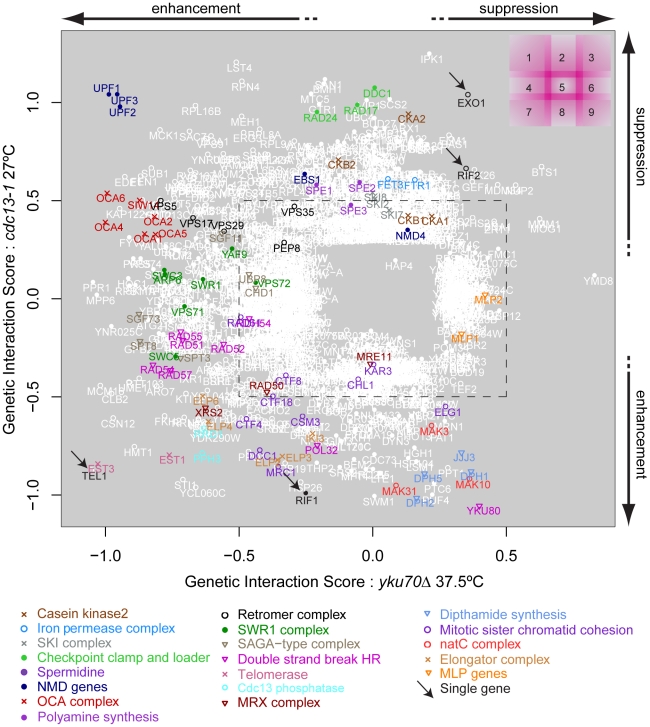
Genetic interaction strength (GIS) comparison between cdc13-1 and yku70Δ.Genes that significantly interacted with cdc13-1 or yku70Δ are shown, most genes did not interact and would be placed in the centre of the plot. Genes encoding components of selected protein complexes (or proteins which work closely together towards the same function) are indicated by colour-co-ordinated text and symbols. Genes that interact with both cdc13-1 and yku70Δ are open white circles, those that interact with just one mutation are filled white circles. Different regions of the plot are indicated on the top right and borders between regions are intentionally blurred/overlapping as there are not precise cut-offs. An arbitrary GIS cutoff of +/−0.5 is indicated by the black dashed rectangle. Also see Figure S3 for further analysis of these data.